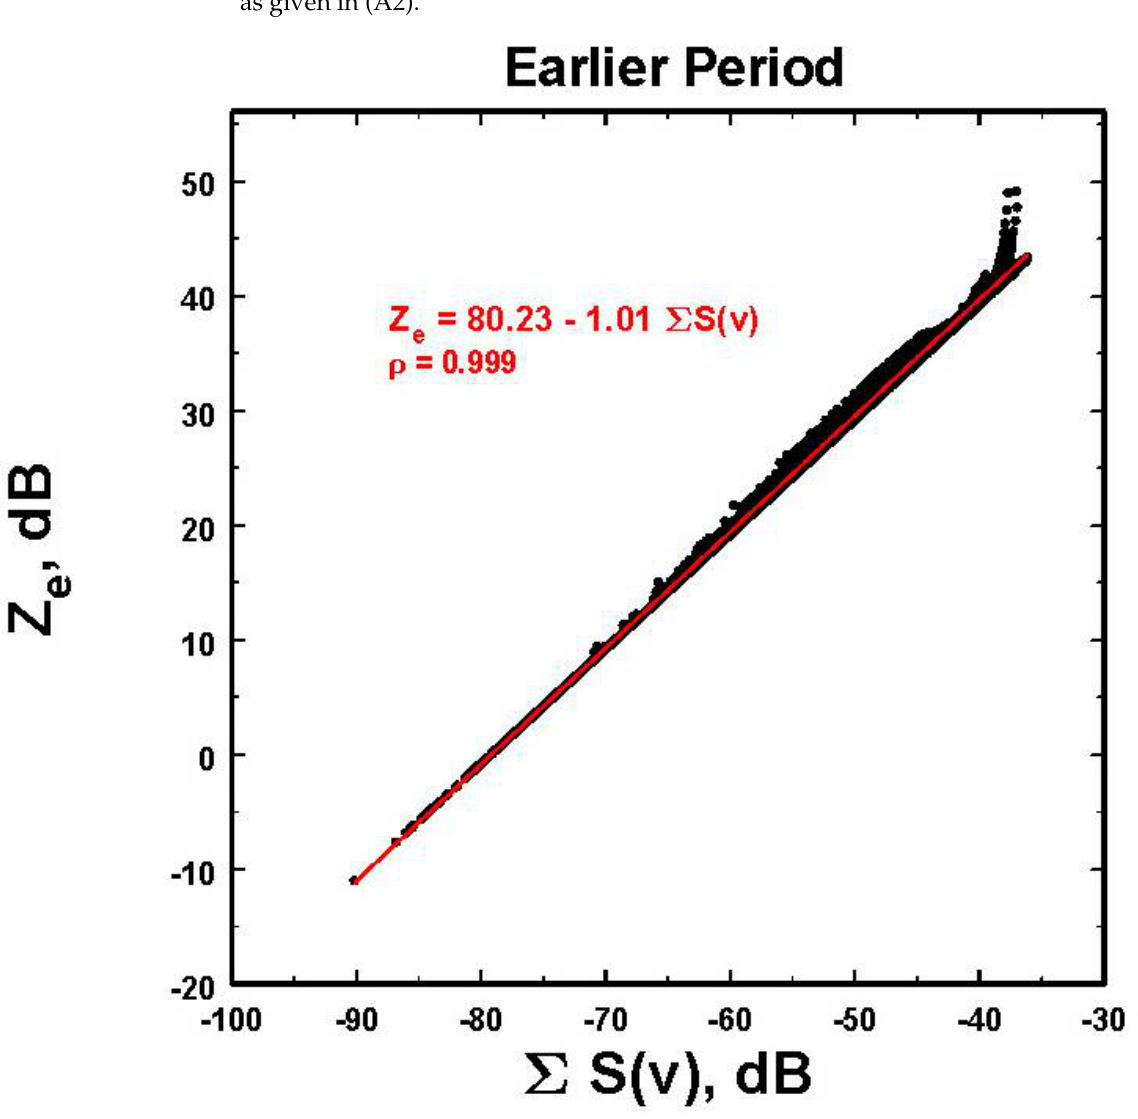
Figure A4. Resulting relation between Z e and ∑ S ( v ) after the adjustments for attenuation to the Ze in Figure A1, as described in the text.